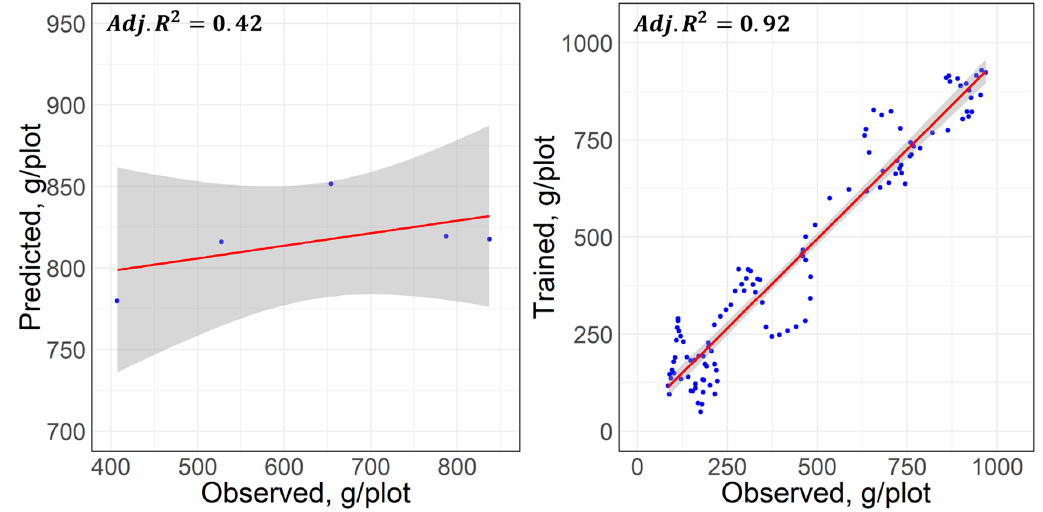
Figure 8. Scatter plots of the observed vs. modeled from a predictive principal component regression (PPCR) model. (Left) Performance of test. (Right) Training.